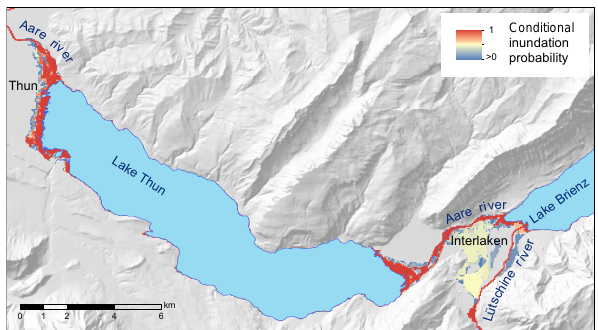
Figure 4. Detailed example of the conditional probability flood map for the floodplains of Thun and Interlaken. Predicted flood inunda- tion extents can change significantly depending on the specific spa- tial properties of a few of the PMP scenarios and hence have lower mapped inundation